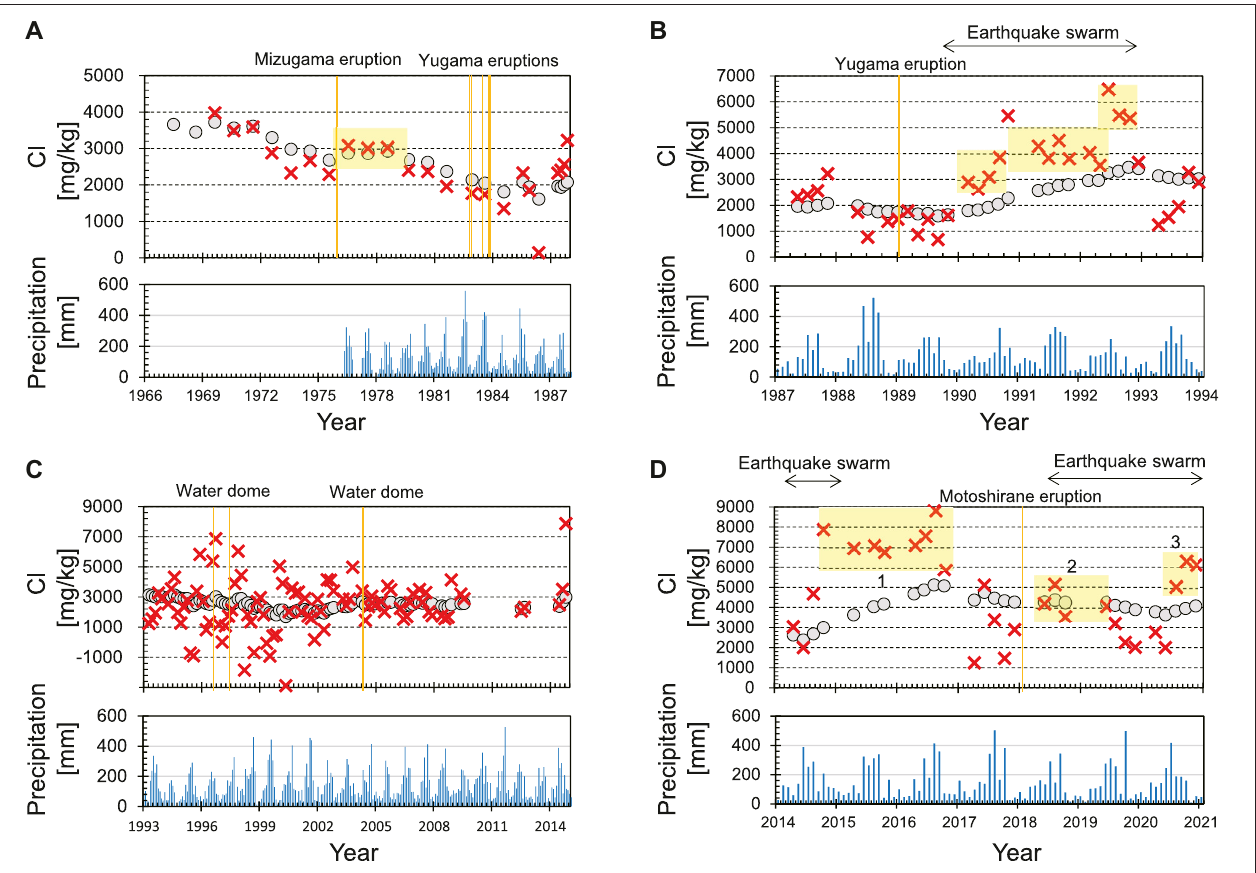
FIGURE6 | Smoothed C i values (gray circles) and computational results for C i eq (red crosses) using the three data calculation ( Eq. 13 ) and monthly precipitation at Kusatsu town, whichis6 kmeast ofYugama craterlake,asmeasured bythe JMA foreach time period. Theyellow vertical lines representeruptionsatKusatsu – Shirane volcanoorunusualturbulence eventsonthesurfaceofYugamacraterlake. (A) Perioda,1966 – 1986, (B) period b,1987 – 1993, (C) periodc,1994 – 2013and (D) period d, 2014 – 2020.